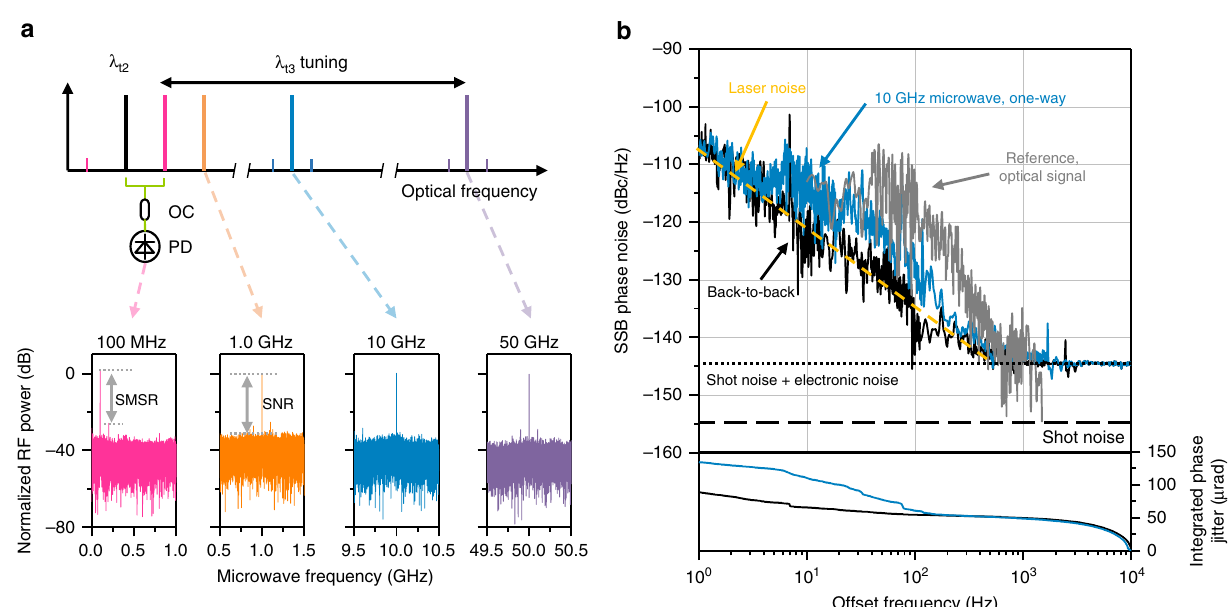
Fig. 4 Microwave signal transfer. a Microwave synthesis by heterodyning two optical carriers λ t2 and λ t3 . Abbreviations are; OC: optical coupler, PD; photodetector, SMSR: side-mode-suppression ratio, SNR: signal-to-noise ratio. b Phase noise spectra of a 10 GHz microwave measured at Site A (black) in back-to-back con fi guration and at Site B (blue) after transmission over an 18 km free-space optical link. The reference optical signal (grey) is plotted by downscaling the uncompensated optical phase noise shown in Fig.